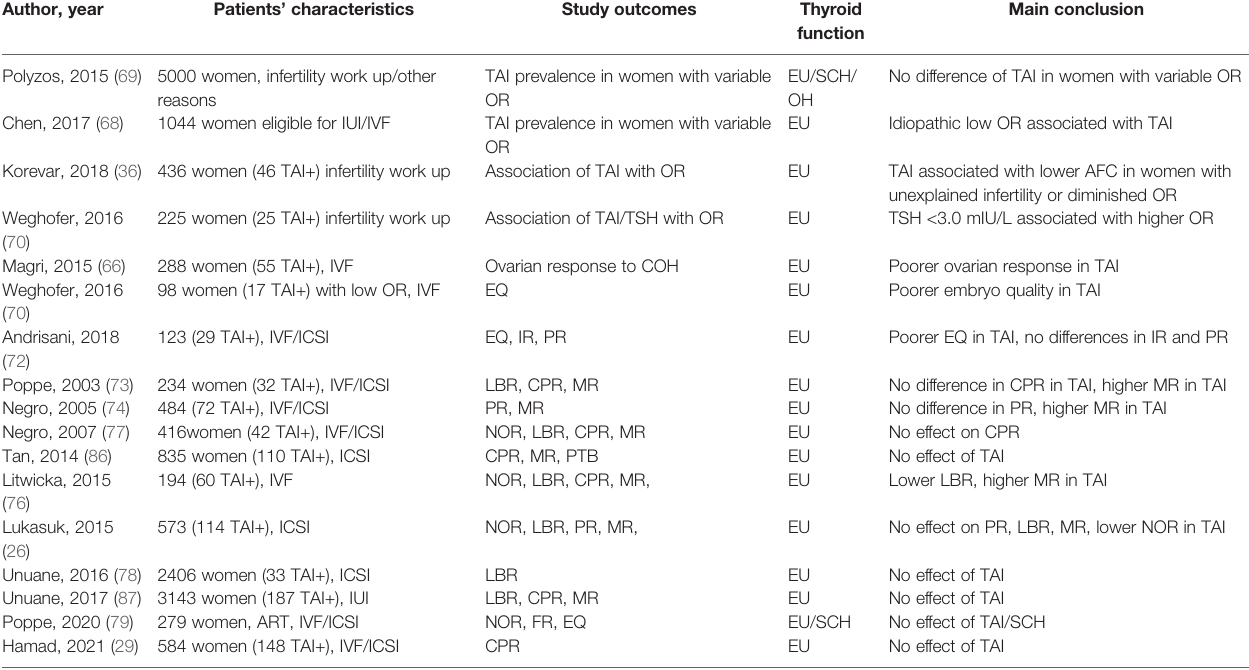
TABLE 2 | Studies addressing the effect of TAI on ovarian reserve/response and on assisted reproductive technology (ART)